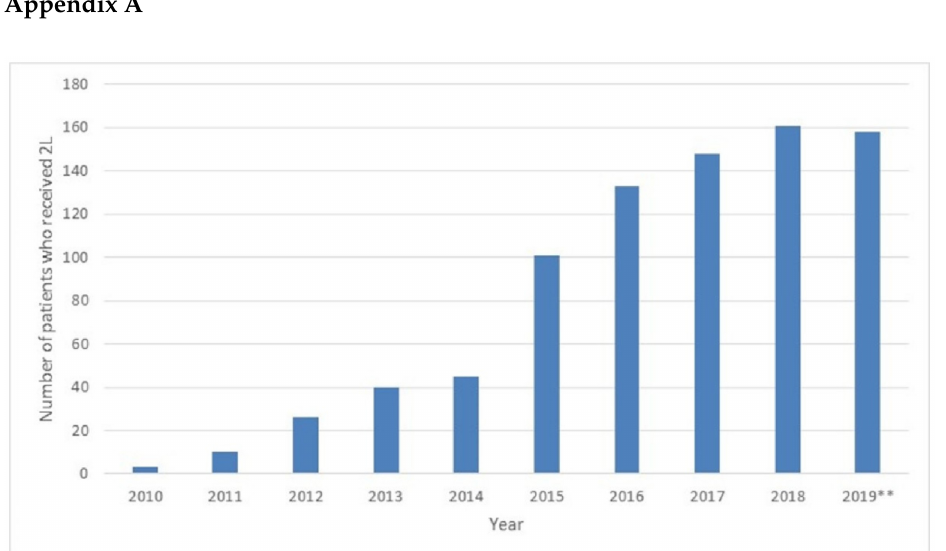
Figure A1. Number of patients who received second line treatment during study period. 2019**: Data available until August 2019.